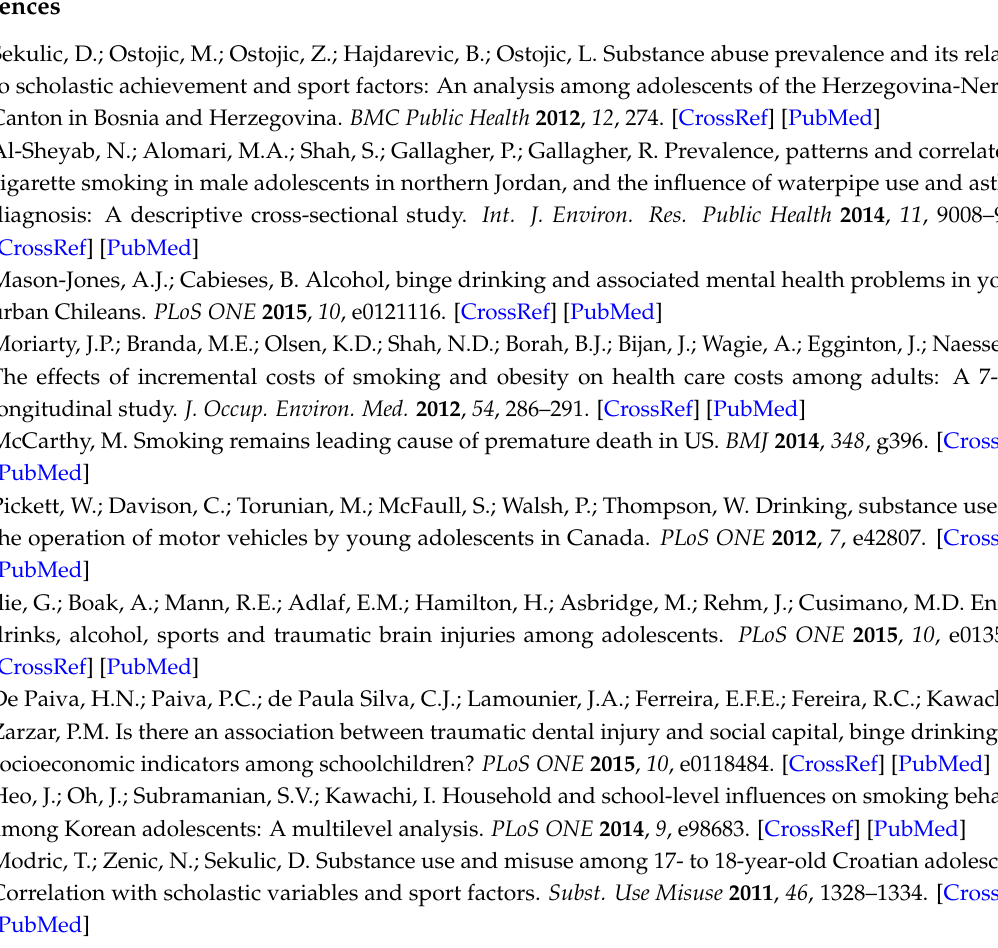
Table S1: Decriptive data (frequencies—f, and percentages—%) for the studied scholastic-, sport, and familial-factors, Table S2: Decriptive data (frequencies—f, and percentages—%) for cigarette smoking and consumption of other drugs, Differences between genders (Kruskal Wallis test H, level of significance—p). Acknowledgments: The financial support of the University of Split, Faculty of Kinesiology was used to cover the costs of open access